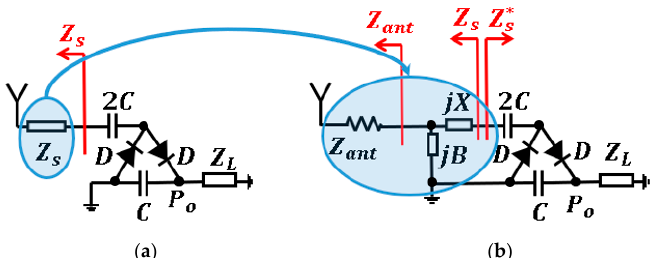
Figure 13. Design procedure of the matching circuit. Obtaining the optimum source impedance Z s ( a ) and implementing the matching circuit ( b ).